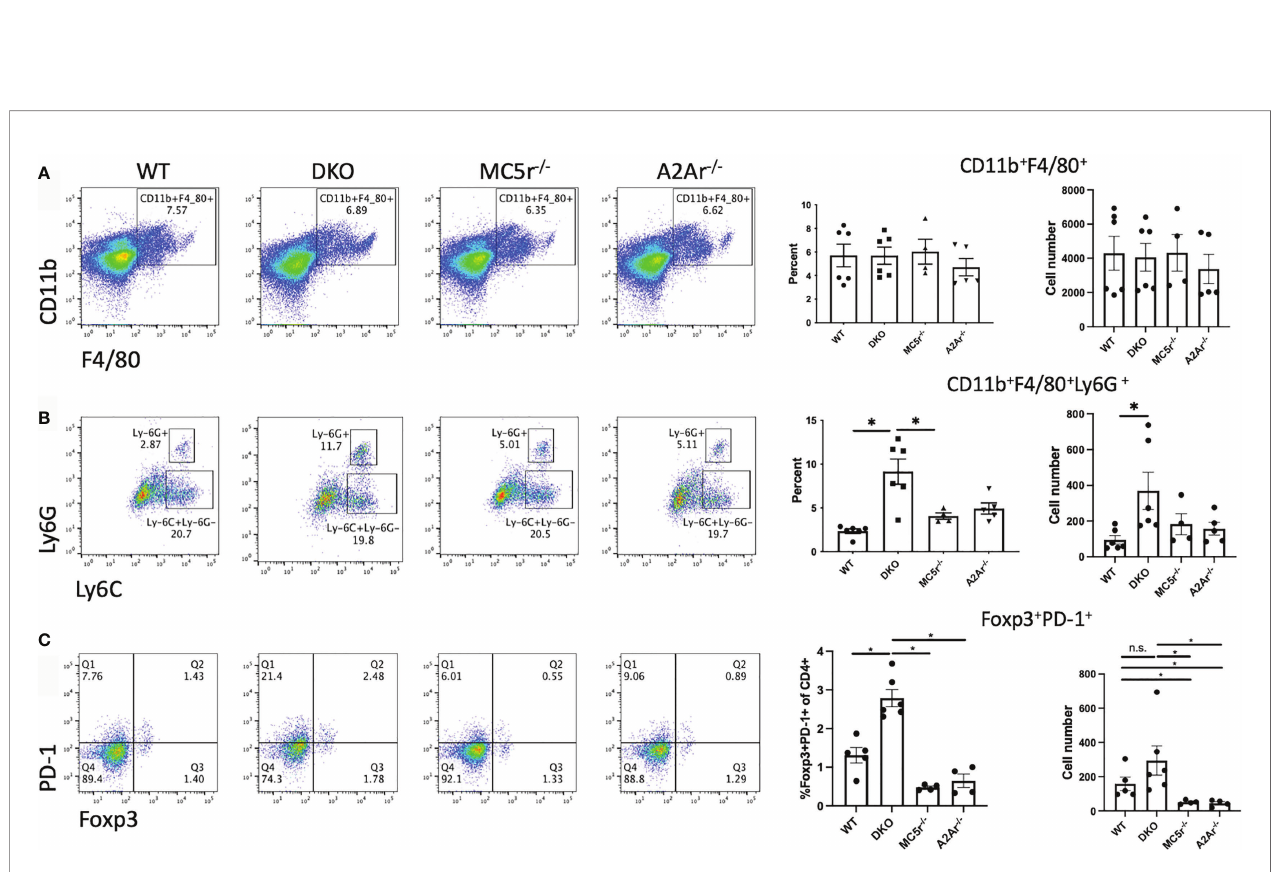
FIGURE 2 | Comparison of APC and Tregs in naïve DKO with WT, MC5r -/- , and A2Ar -/- mice. Spleens from naïve WT (N=6), DKO (N=6), MC5r-/- (N= 4), and A2Ar-/- (N = 5) were collected and stained for CD11b, F4/80, Ly6G, Ly6C, CD4, PD-1, and Foxp3. Representative pseudocolor dot plots and the mean ± SEM for each mouse are shown for CD11b and F4/80 (A) , Ly6G and Ly6C (B) , and PD-1 and Foxp3 (C) . The Ly-6G and Ly6C panels are gated on CD11b + F4/80 + cells, and PD-1 and Foxp3 panels are gated on CD4 + cells. Each experiment consisted of 1-2 mice, and each experiment was repeated 2-3 times. Signi fi cance was assessed by nonparametric Mann-Whitney U test. Statistical signi fi cance (P ≤ 0.05) is designated by *, or not signi fi cant (n.s.).